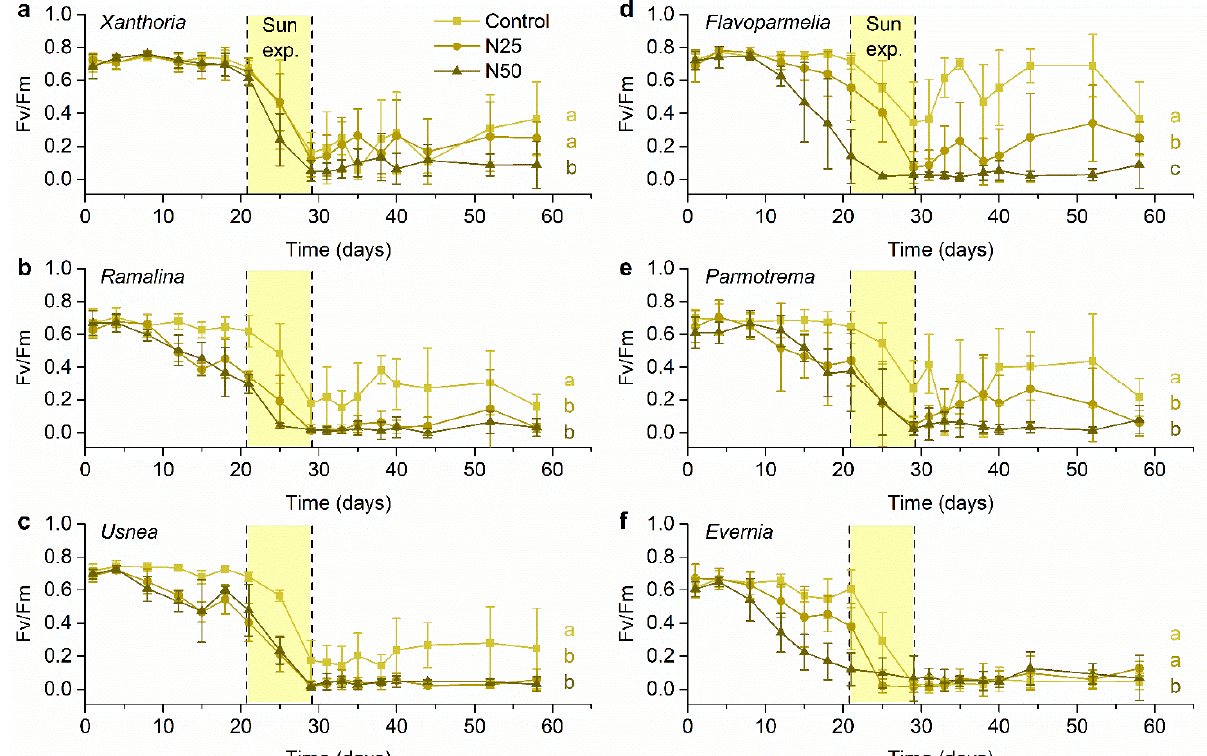
Figure 1. Temporal evolution of Fv/Fm ratio during 58 days for Control (no nitrogen [N] addition), 25 N (treated with 25 mM of (NH 4 ) 2 SO 4 ) and 50 N (treated with 50 mM of (NH 4 ) 2 SO 4 ) for the following species: ( a ) Xanthoria parietina , ( b ) Ramalina lacera , ( c ) Usnea sp., ( d ) Flavoparmelia caperata , ( e ) Parmotrema hypoleucinum , ( f ) Evernia prunastri . All samples were subjected to the same radiation treatment. The period of exposure to direct sunlight is indicated in yellow. Lowercase letters indicate significant differences among N treatments for each species ( n = 5). Table 2. Repeated measures ANOVA analyses for all the studied epiphytic lichens during the first 20 days. The samples were subjected to N treatment alone during this period. Control = No nitro-